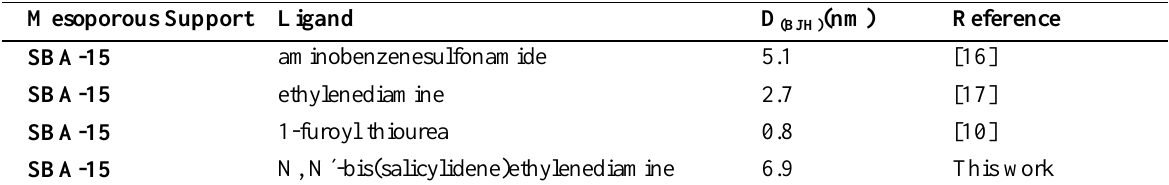
Table 2. The grafting of various ligands on